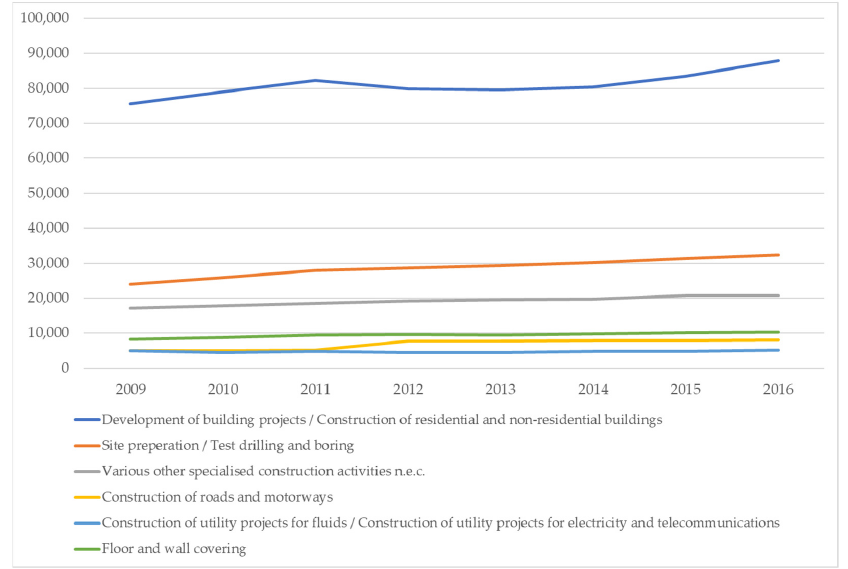
Figure 2. Number of employees in the six largest subtrades, 2009–2016. Based on data from [27].